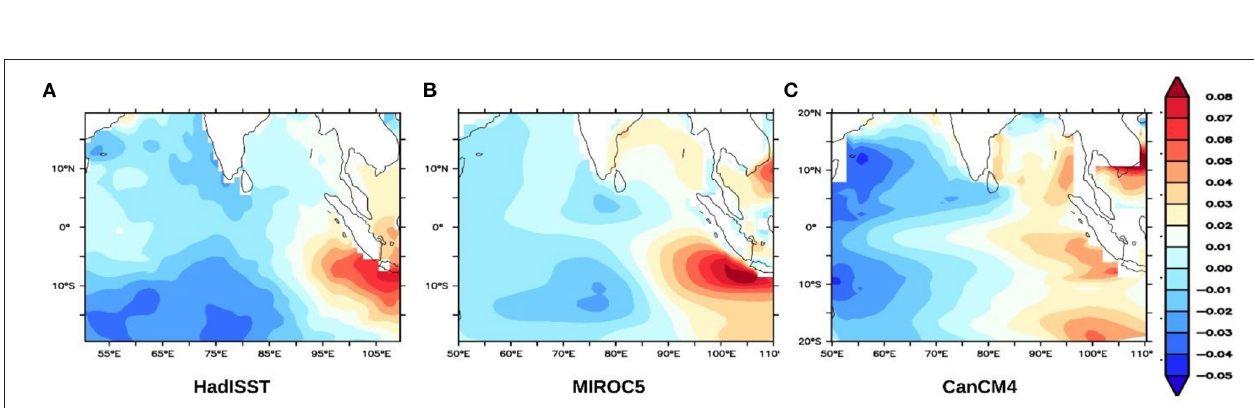
Frontiers in Climate | www.frontiersin.org